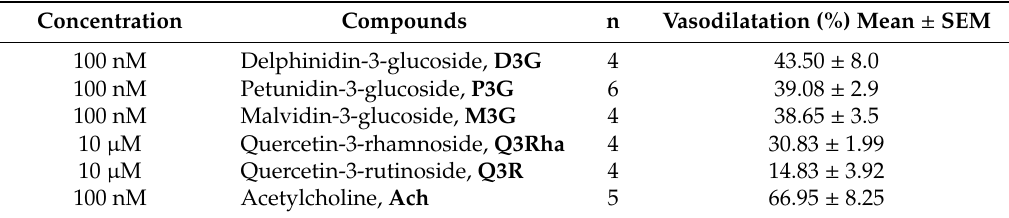
Table 3. Vasodilatation (%) elicited by 100 nM anthocyanins or 10 µ M flavonols in the isolated rat arterial mesenteric bed with intact